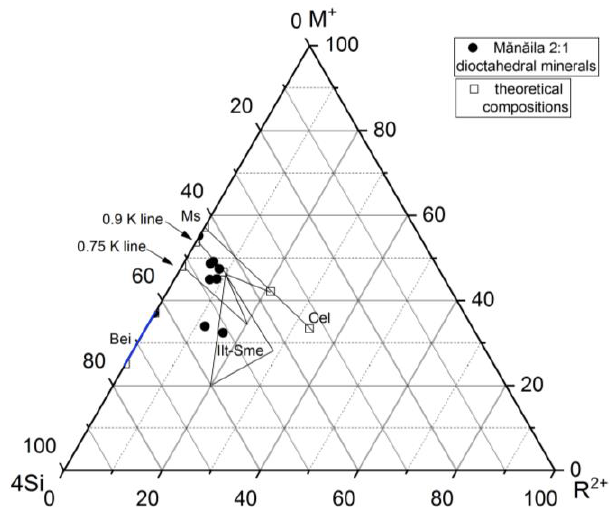
Figure 8. The M + -4Si-R 2+ system for the illite and smectite composition (Bei—beidellite; Cel—celadonite; Ilt—illite; Kln—kaolinite; Sme—smectite).